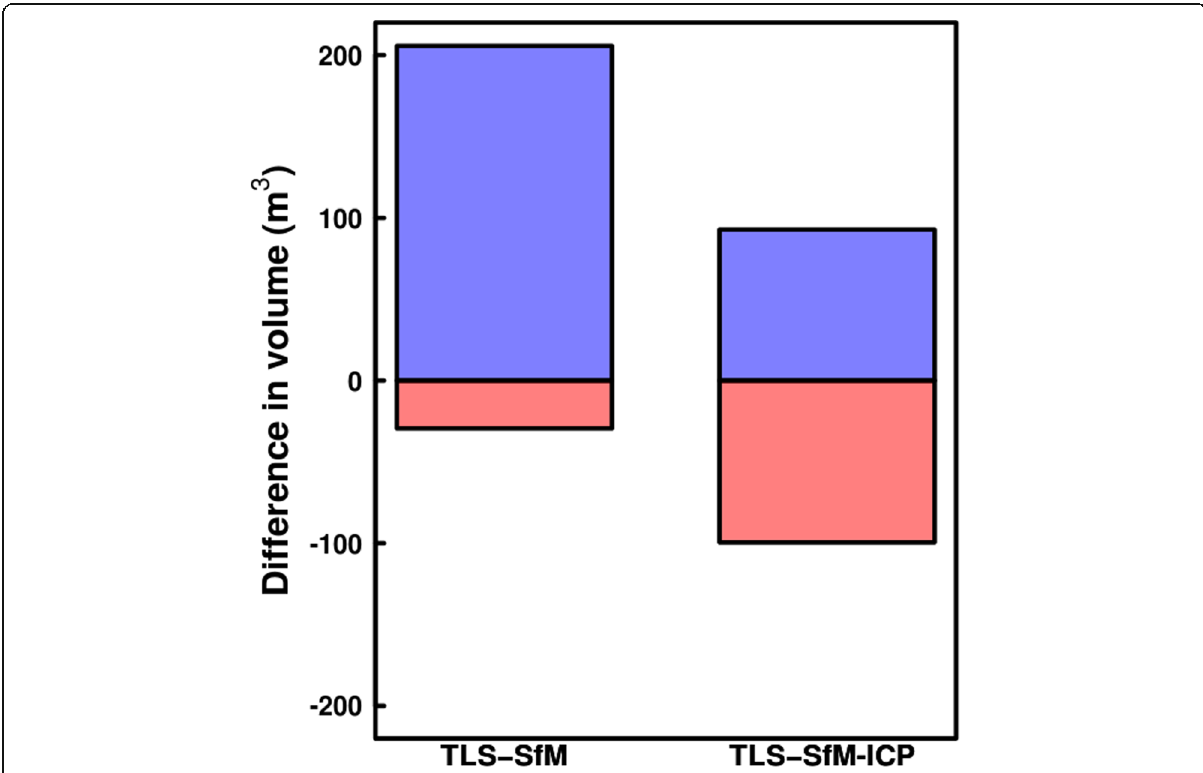
Fig. 5 Difference in volume in the vicinity of the channel bed. Similar to Fig. 2, the cold (positive value) and warm (negative value) colors indicate that the volume of the accumulated domains, DEM SfM or DEM SfM-ICP , is relatively high or low compared with DEM TLS , respectively